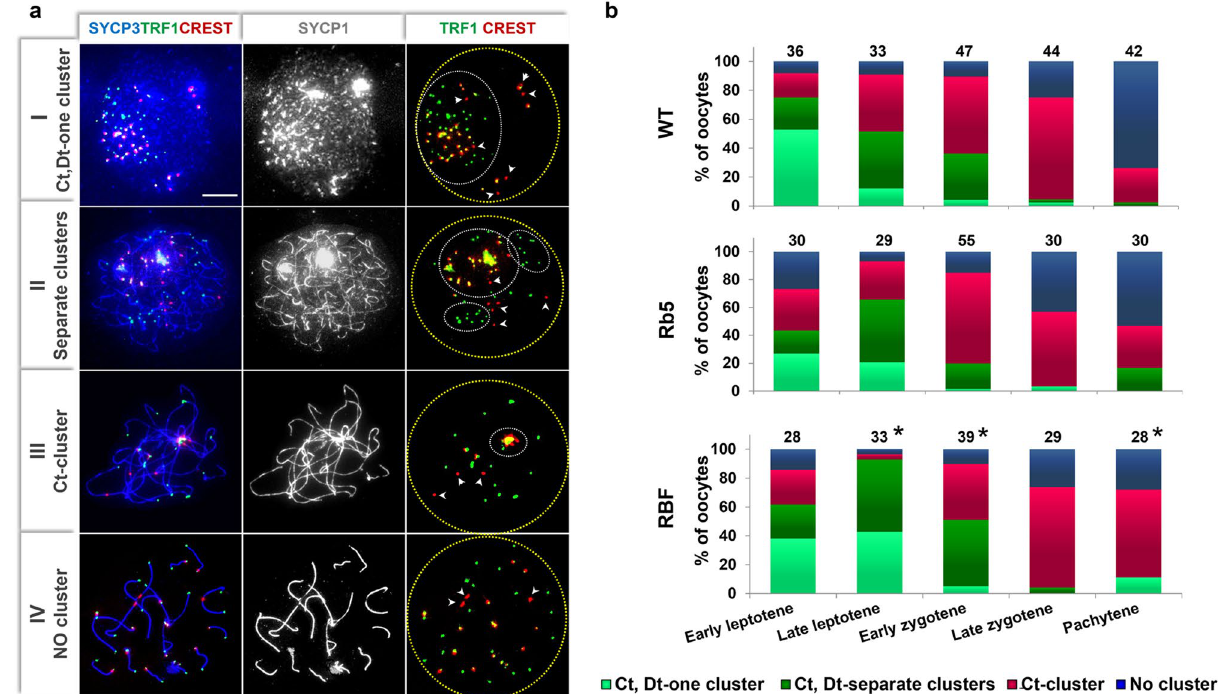
Figure 2. C- and D-telomere clustering and resolution in Rb5, RBF, and WT BALB/c mouse oocytes. ( a ) Representative images showing four types of telomere clustering in RBF oocytes. Telomere clusters are indicated by white broken line circles. RbT-centromeres are marked with arrowheads. Scale bar 10 μm. ( b ) Percentages of oocytes having each type of telomere clusters at progressive MPI substages. The total number of examined oocytes is given on the top of each column. Four females were examined in each strain. *Significant difference between RBF and WT or Rb5 oocytes at P < 0.05 by χ 2